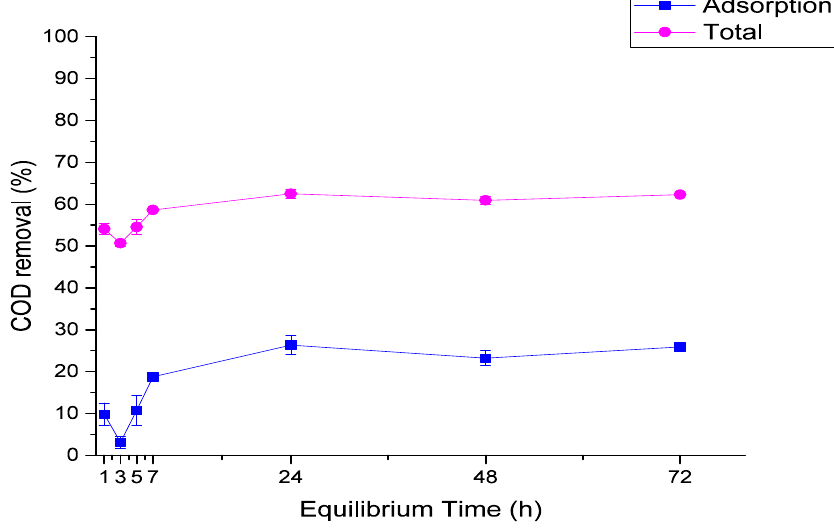
Figure 1. Effect of equilibrium time on COD removal.